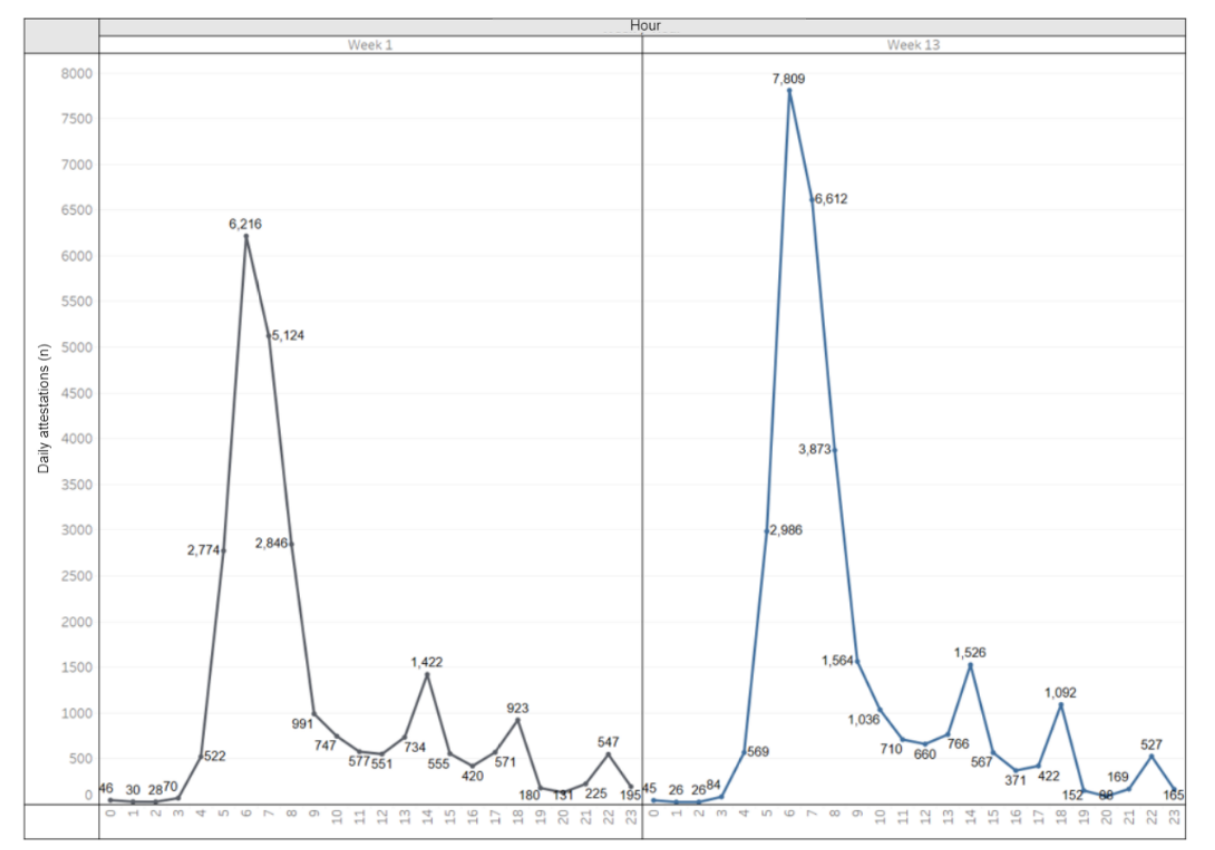
Figure 7. Average daily employee attestations from Monday to Friday (COVID Pass, manual screening, and kiosk) by hour of day during Week 1 (March 30 to April 3, 2020) and Week 13 (June 22 to 26,